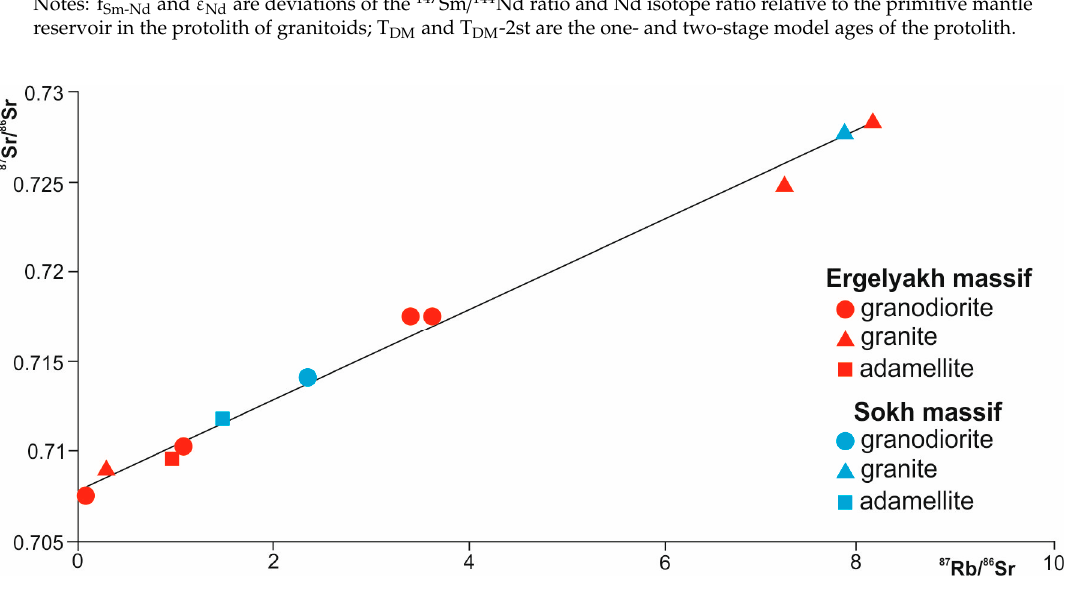
Table 8. Model Sm–Nd age and parameters of protoliths for EIRGD granitoids. Sample